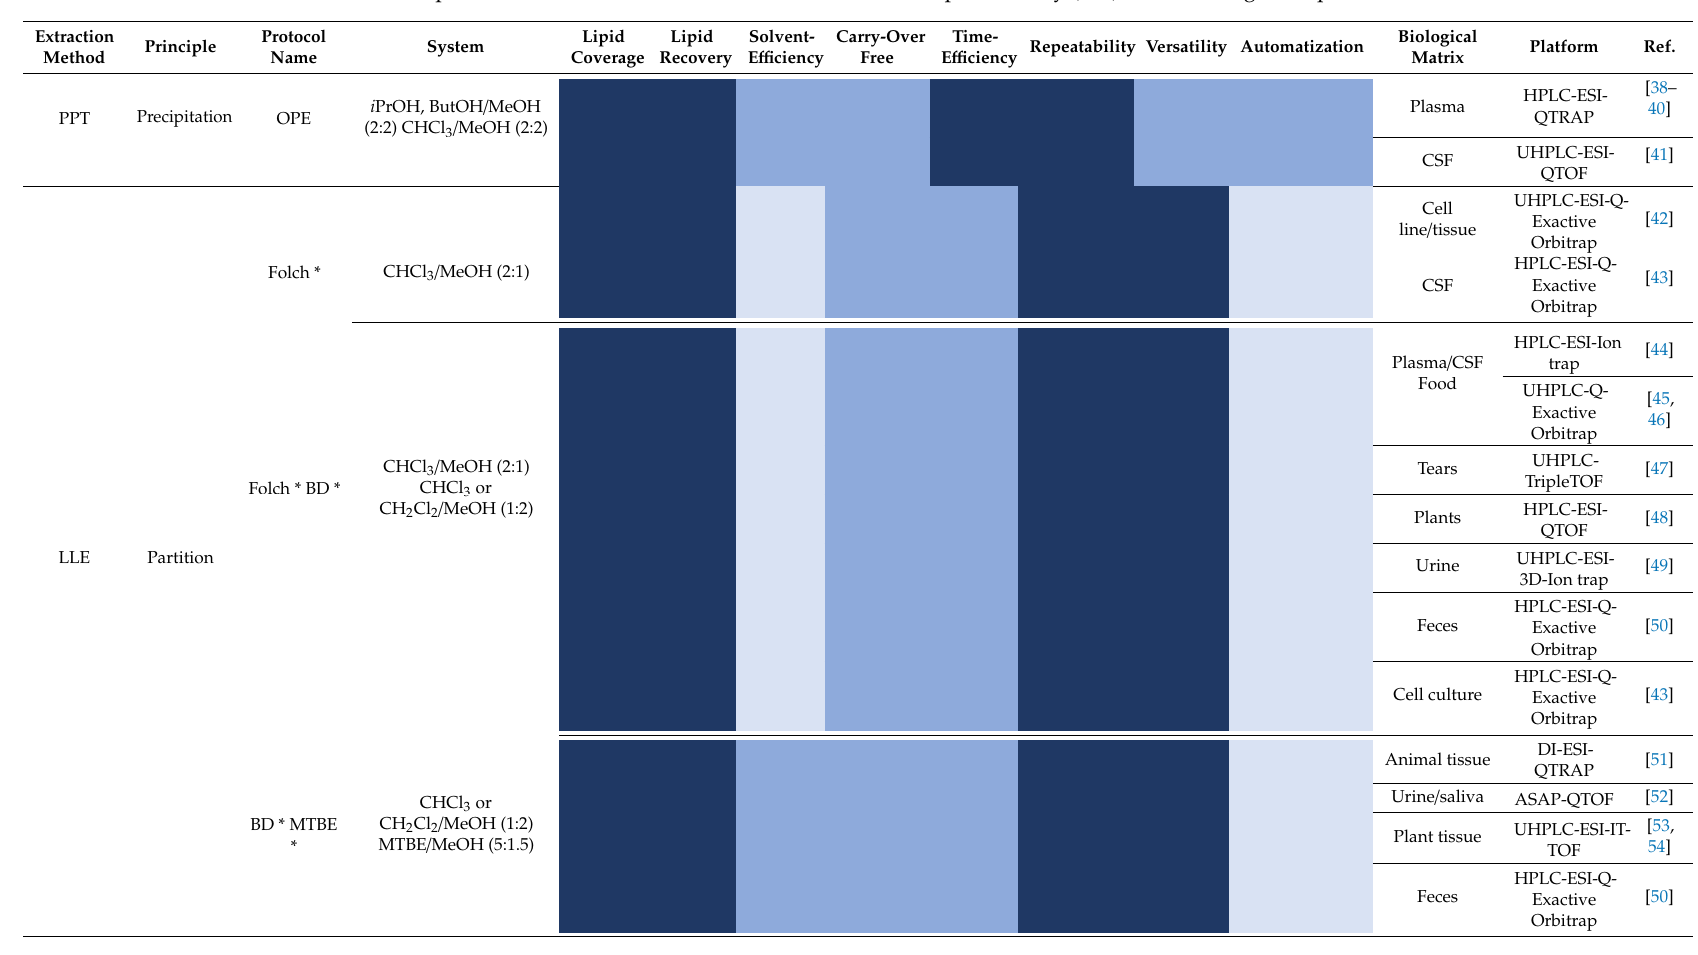
Table 2. Comparison between extraction methods used in mass spectrometry (MS)-based untargeted